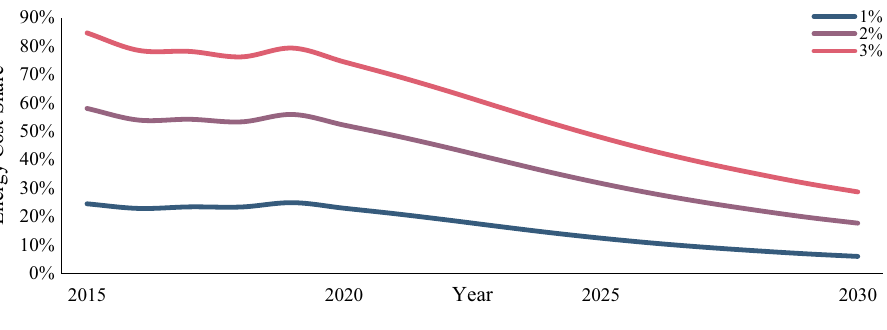
Note: 1%, 2%, and 3% refer to the 1%, 2%, and 3% tax scenarios respectively